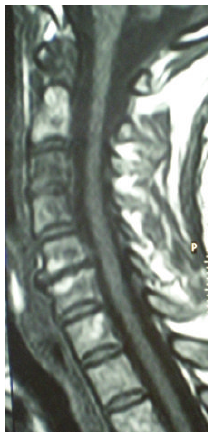
Figure 1: MRI sagittal view of the cervical spine showing a C5-C6 degenerative disc disease and generalized spondylosis of the entire cervical spine.